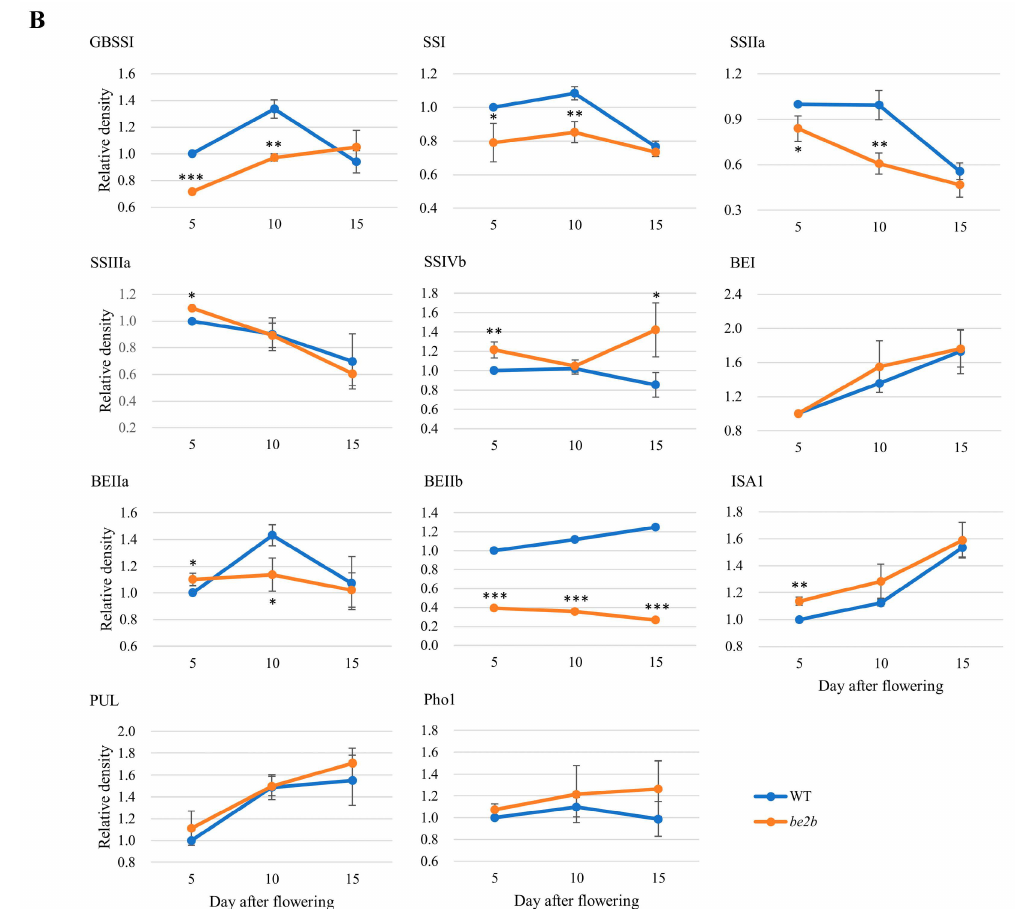
Figure 1. The expression of starch biosynthetic related enzymes (SSREs) during different grain-filling stages (5 DAF, 10 DAF, 15 DAF) in wild type (WT) and be2b mutant: ( A ) Total proteins were separated by SDS-PAGE. Each lane was loaded with 50 µ g of proteins. Gels were analyzed by Western blotting using the indicated isozyme-specific antibodies. The anti-actin antibody is used as a loading control. Results shown are representative of two biological replicates. ( B ) Relative density of Western blotting results measured by Image J. Data are Mean ± SD from two biological replicates. The asterisks indicate statistical significance between WT and be2b , as determined by the Student’s t -test (*, p < 0.05; **, p < 0.01; ***, p <